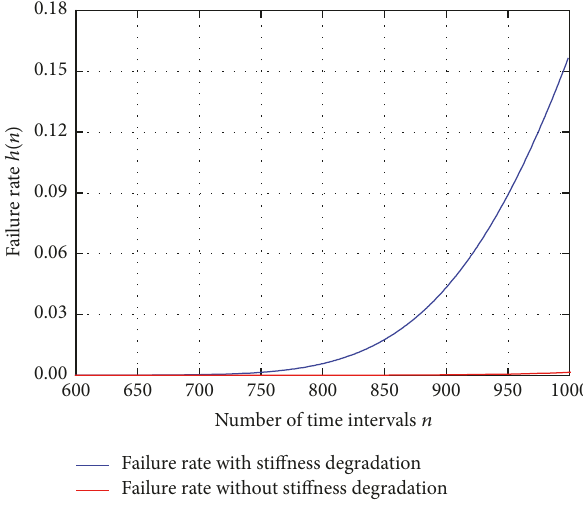
Figure 5: Failure rate of belt drive systems.